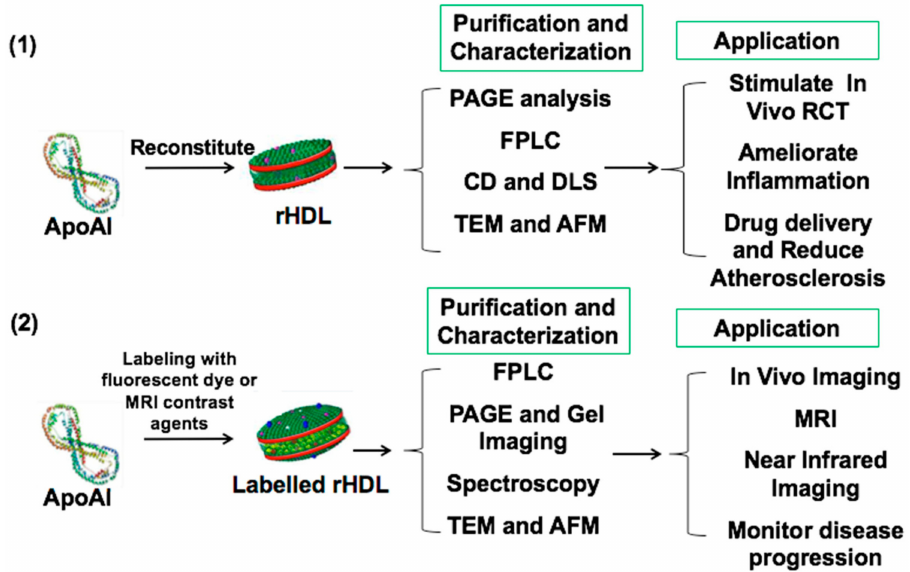
Figure 2. Synthesis and characterizations of rHDL and rHDL imaging probes. rHDLs are made up of reconstituted apoAI and phospholipids. rHDLs are characterized by biochemical approaches such as polyacrylamide gel electrophoresis (PAGE) analysis, and transmission electron microscopy (TEM) or atomic force microscopy (AFM) for measuring dimensions of rHDL nanoparticles after purification with fast protein liquid chromatography (FPLC). The biophysical properties of the rHDL particles is determined by using dynamic light scattering (DLS) and circular dichroism (CD) spectroscopy. rHDLs can be labeled with fluorescent dye or MRI imaging contrast agents for in vivo imaging